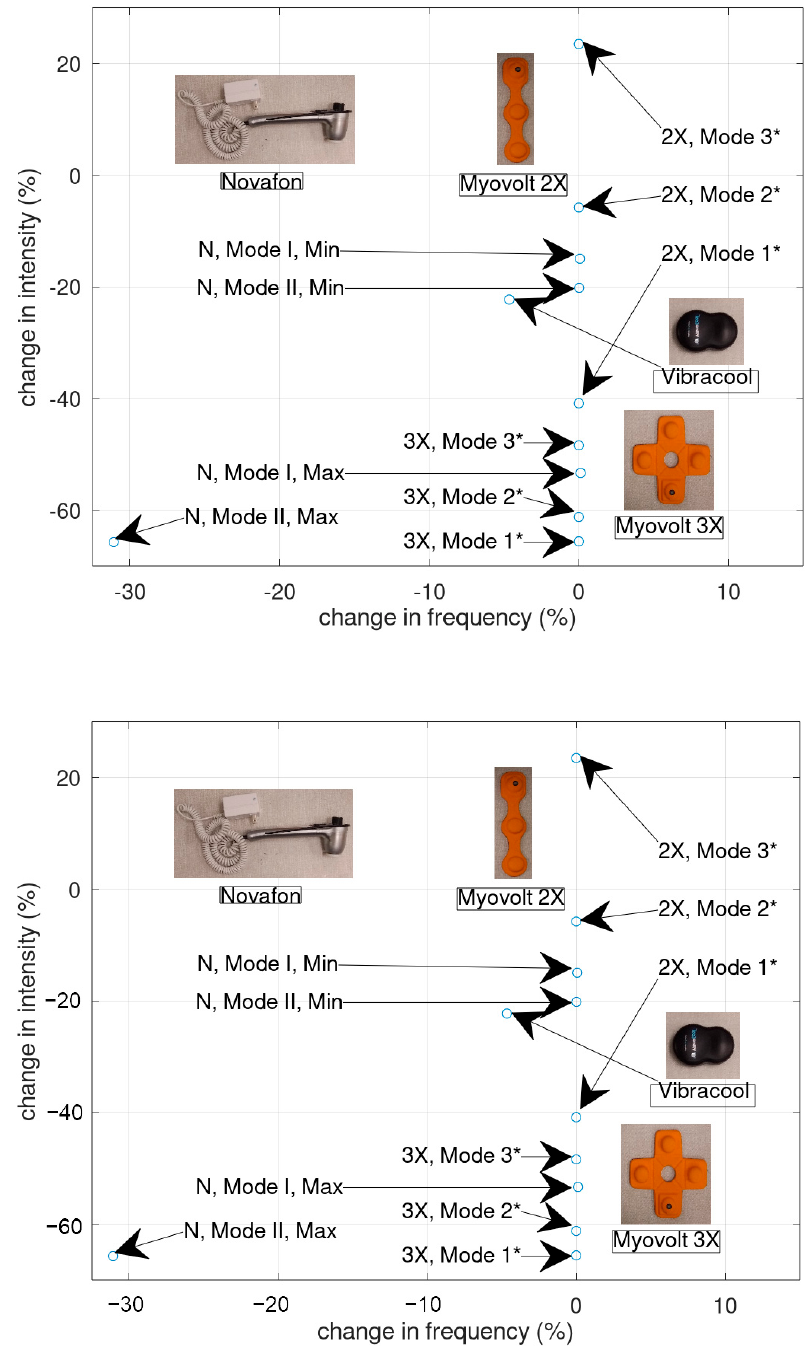
Figure 6. Change in frequency and peak-to-peak intensity measured for the four FV devices for the constrained vibration setup. The change shown is relative to the free vibration case. Negative numbers indicate a decrease. “*” indicates that the maximum peak-to-peak intensity was measured, and frequency was not measured.